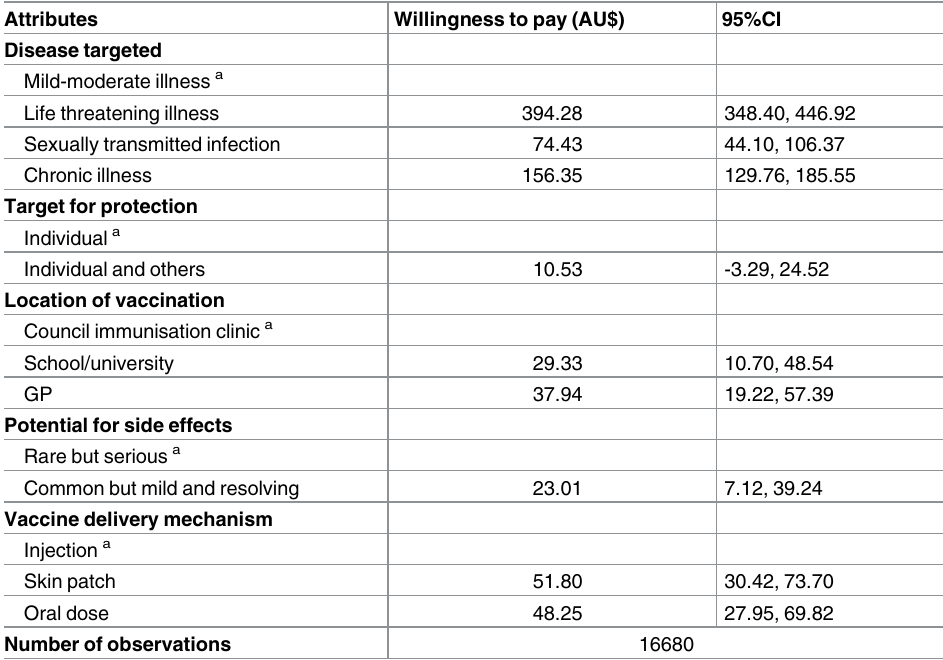
Table 4. Willingness to pay (AU$) for vaccination (based on mixed logit